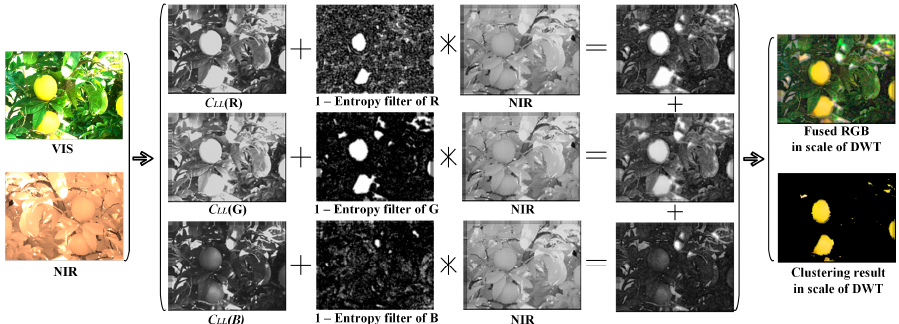
Figure 8. Fusion of two aligned images using RGB components with fusion rule.